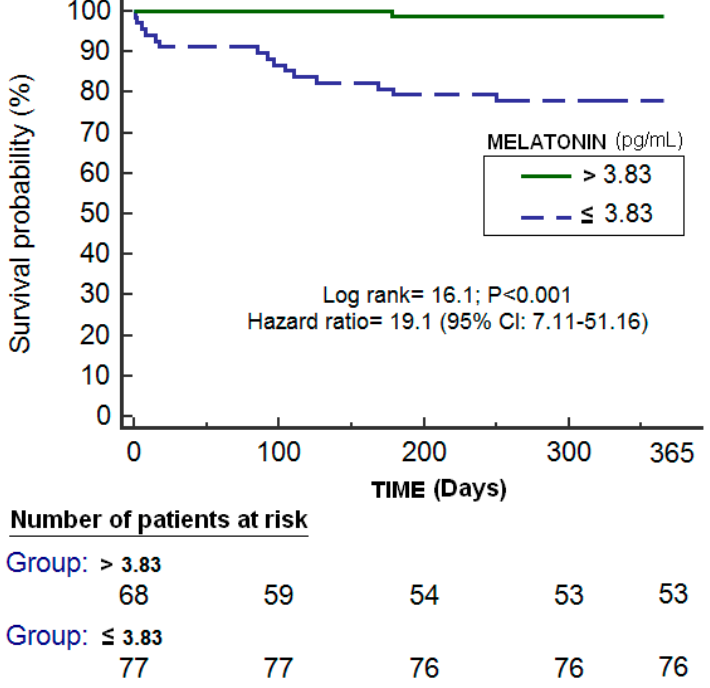
Figure 2. Kaplan–Meier survival analysis using one-year liver transplantation mortality (as dependent variable) and serum melatonin levels prior to liver transplantation lower/higher than 3.83 pg/mL (as independent variable).